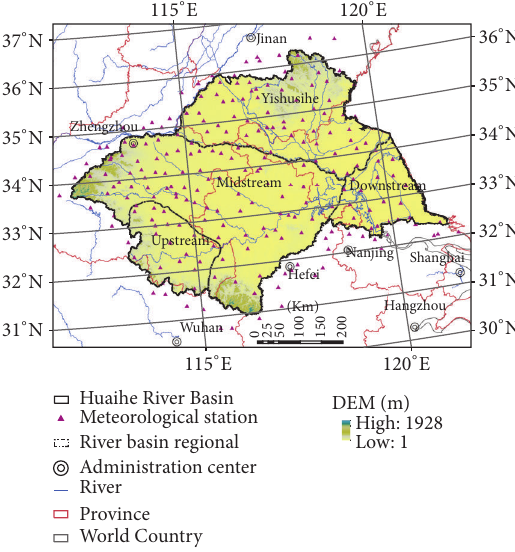
Figure 2: The 229 national meteorological stations in the Huai River Basin.